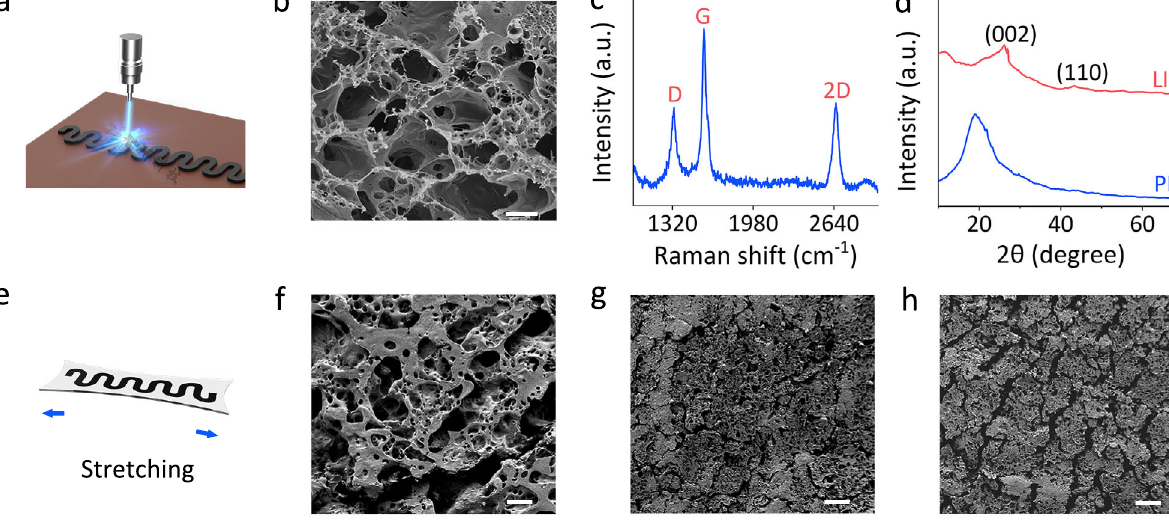
Fig. 3 Morphology characterization of LIG before and after being transferred. a The diagram of LIG before being transferred. b The SEM image of LIG. c The Raman spectrum of LIG. d The XRD analysis of LIG. e The diagram of transferred LIG. f , g The SEM images of transferred LIG. h The SEM morphologies of transferred LIG under 5% of strain. Scale bars: b = 5 μ m, f = 20 μ m, g, h = 200 μ